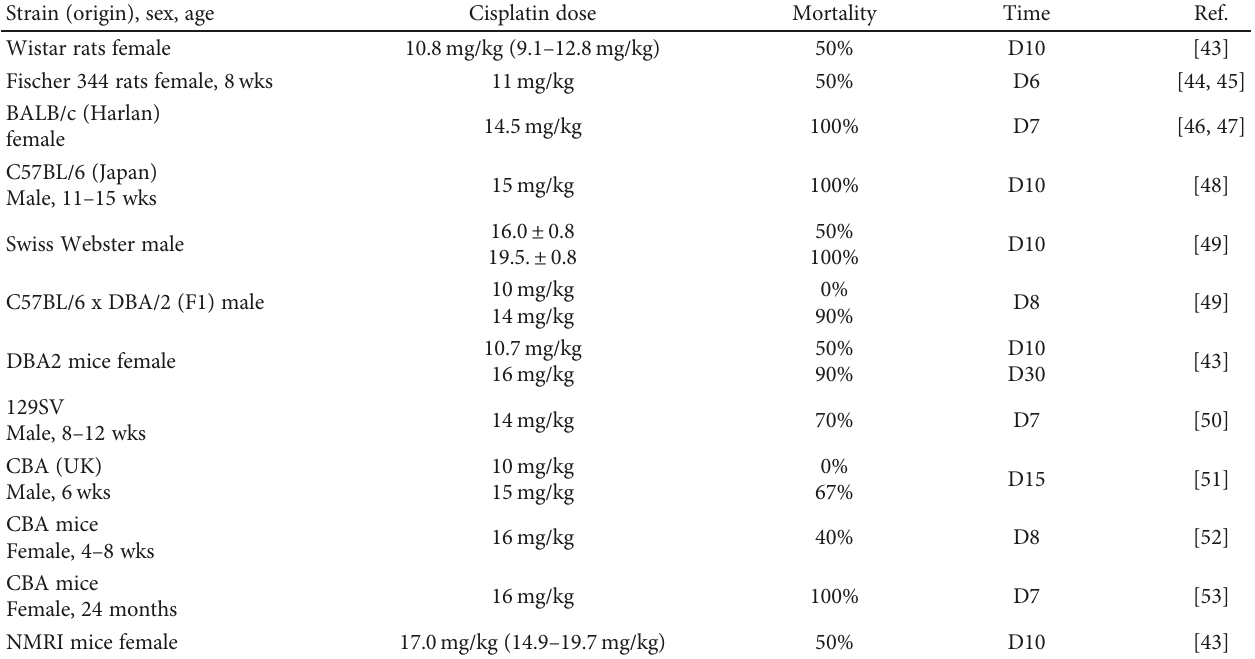
Table 3: The acute lethal single dose of cisplatin varies among various strains of mice and